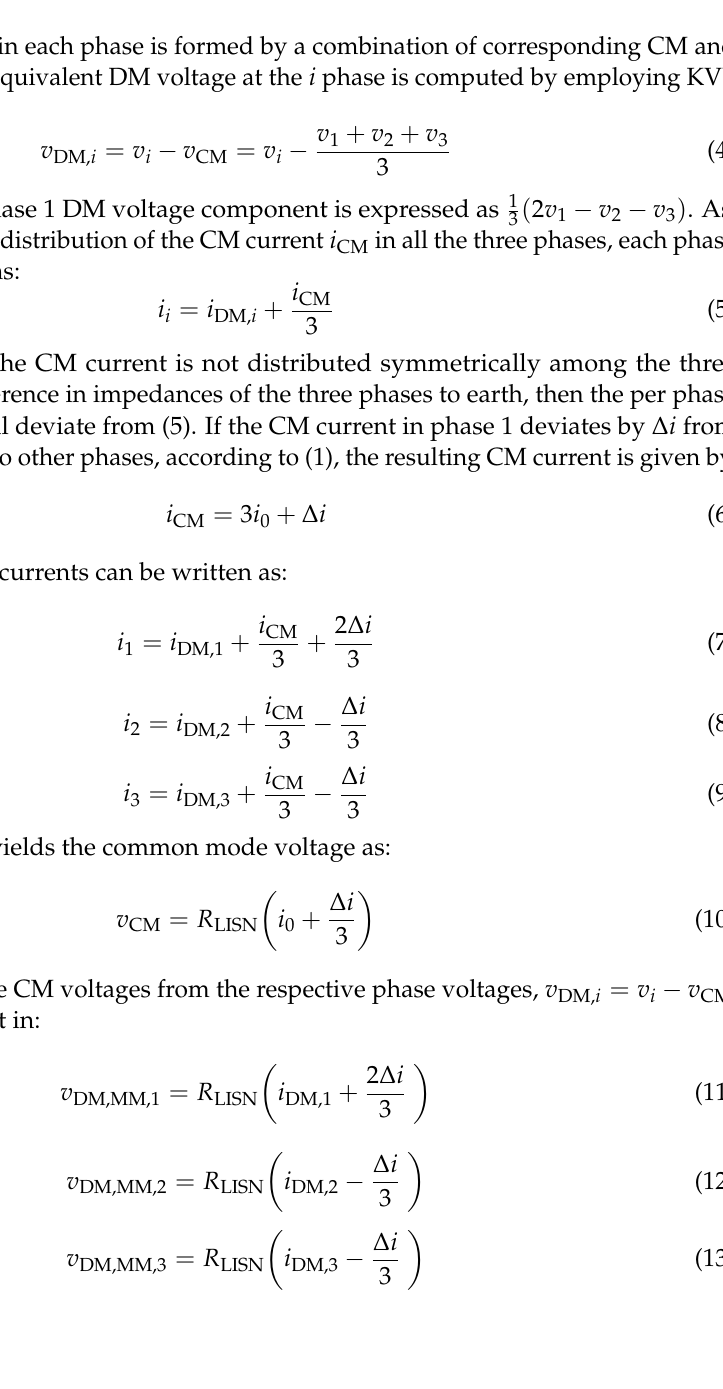
Figure 2. Converter Noise Model with LISN.